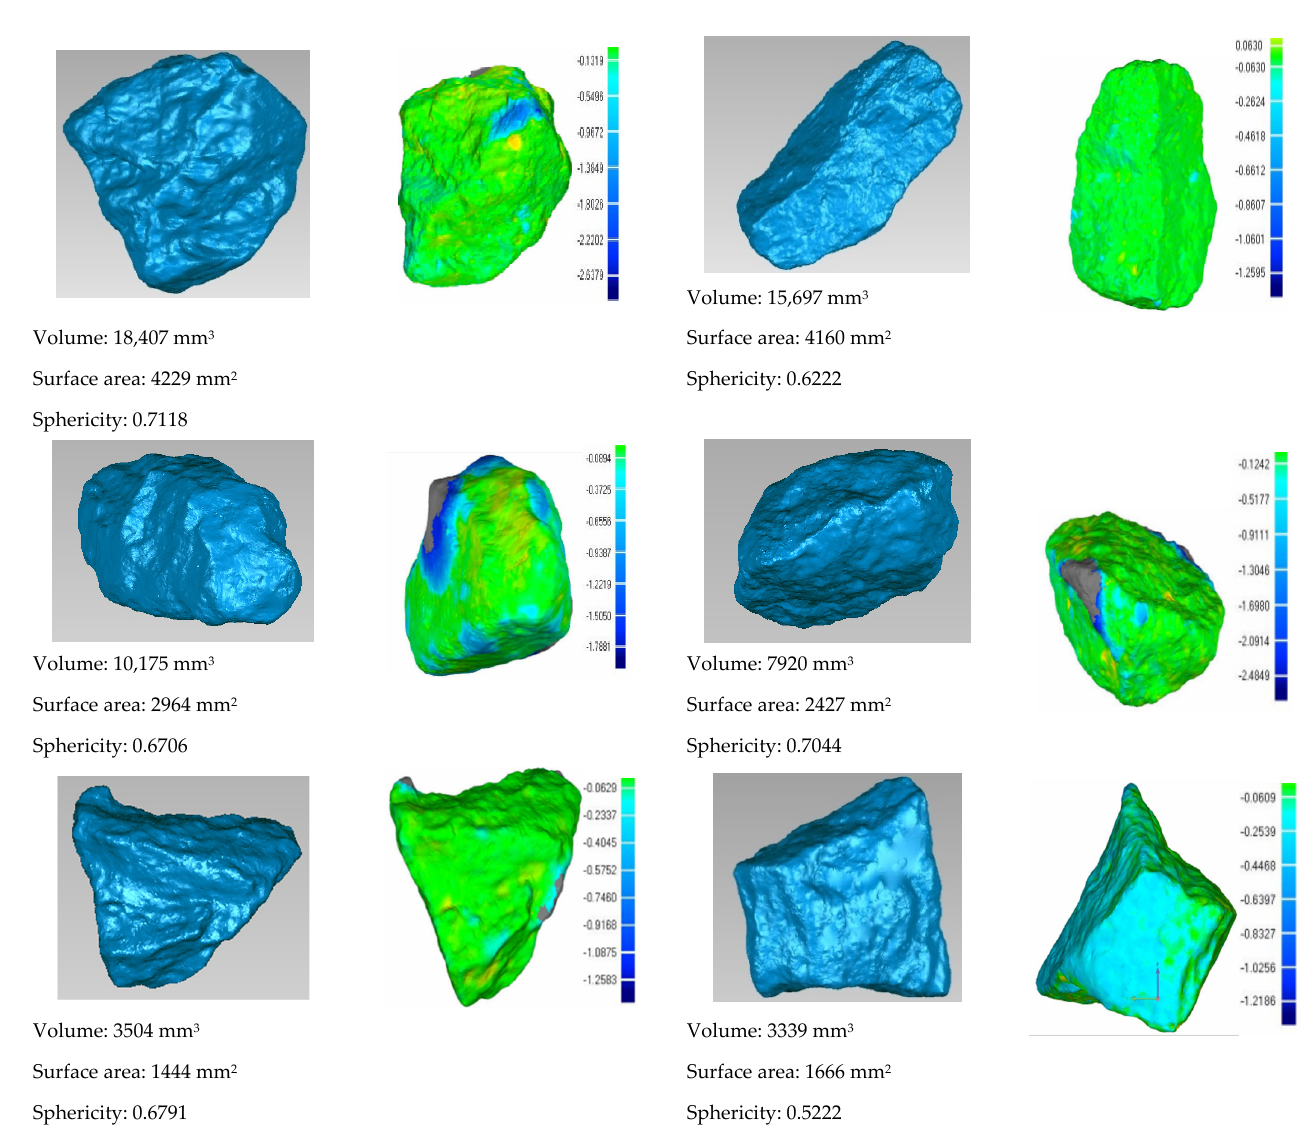
Figure 21. Contour plots of abrasion depth of example coarse particles determined from the comparison of digitized particle shape before and after gyratory compaction.